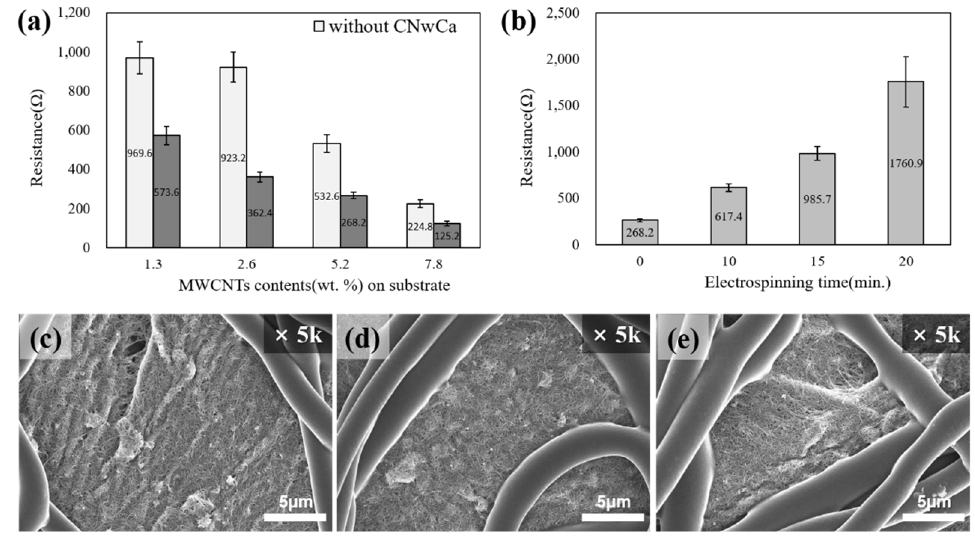
Figure 4. Resistance of the conductive nonwoven MWCNT composite after the spraying process with respect to the ( a ) MWCNT content and ( b ) electrospinning duration. SEM images at electrospinning duration of ( c ) 10 min, ( d ) 15 min, and ( e ) 20 min.